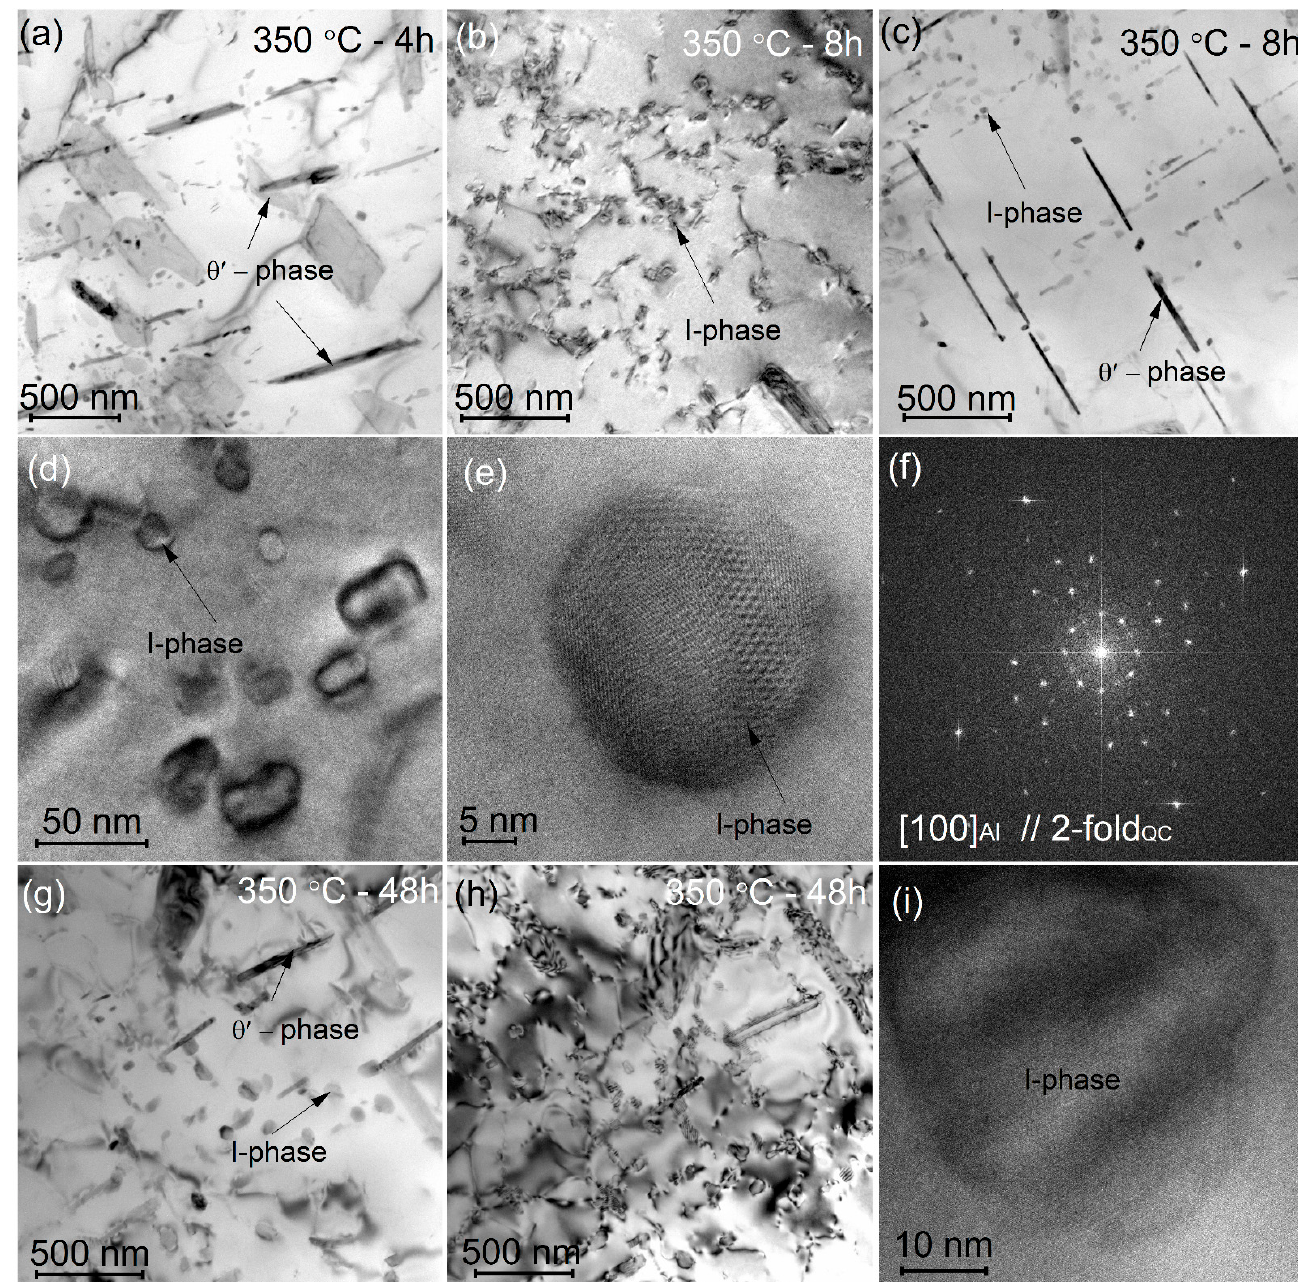
Figure 6. ( a – d , g , h ) Bright field TEM images of the Al-2%Cu-2%Mn alloy subjected to aging for ( a ) 4 h, ( b – f ) 8 h, and ( g – i ) 48 h at 350 °C; ( e , i ) high-resolution images; ( f ) FFT of high resolution image ( e ). Heat treatment at 400 °C for 3 h led to a high number density of precipitates with a size in a range of 41 nm to 120 nm, respectively (Figure 7). The diffraction pattern after 3